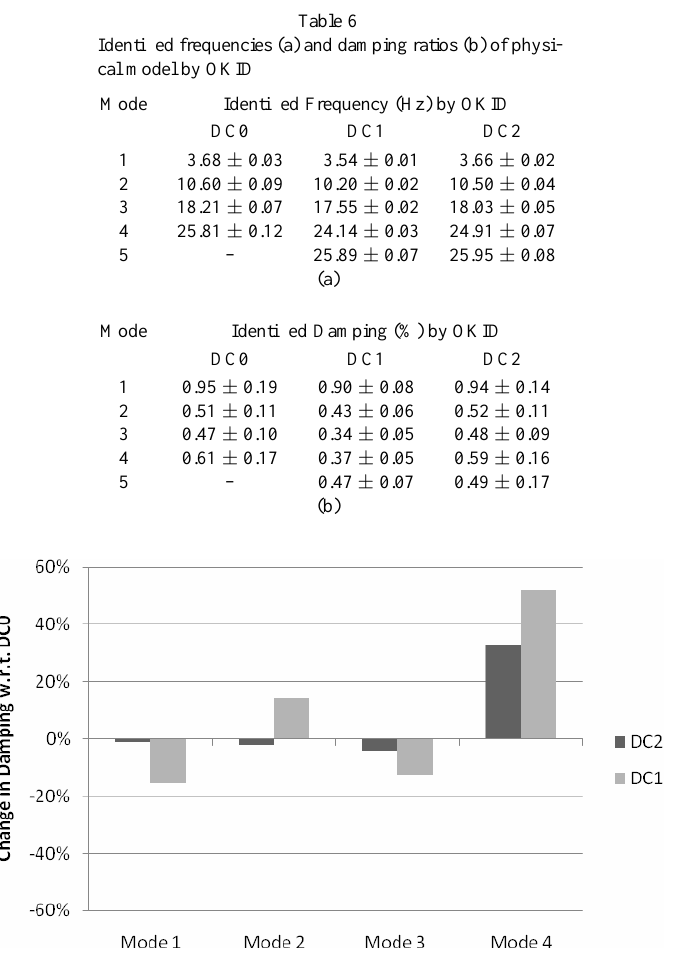
Fig. 15. Change in identified modal damping ratios due to damage